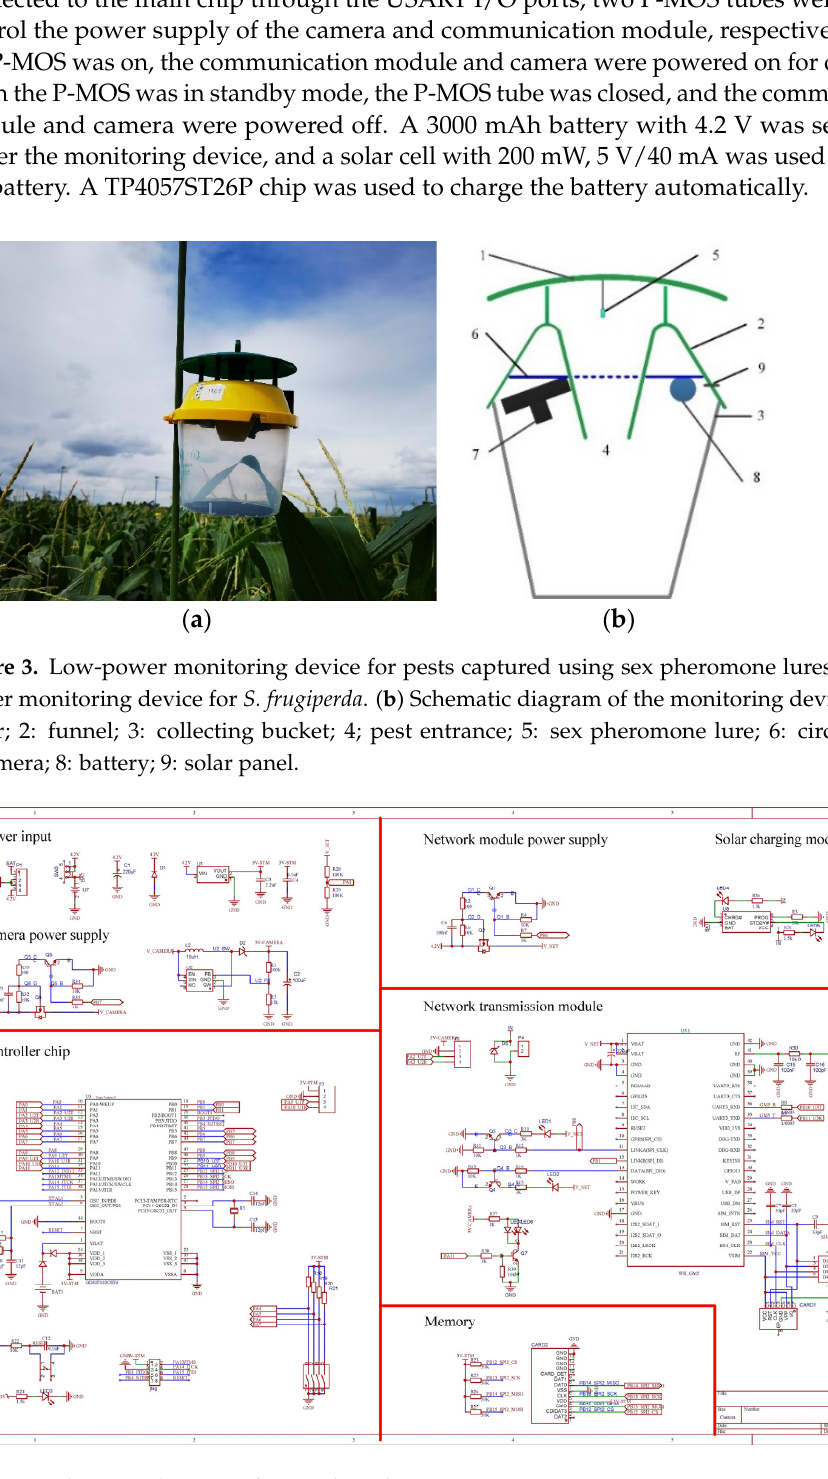
Figure 4. Schematic diagram of circuit board.